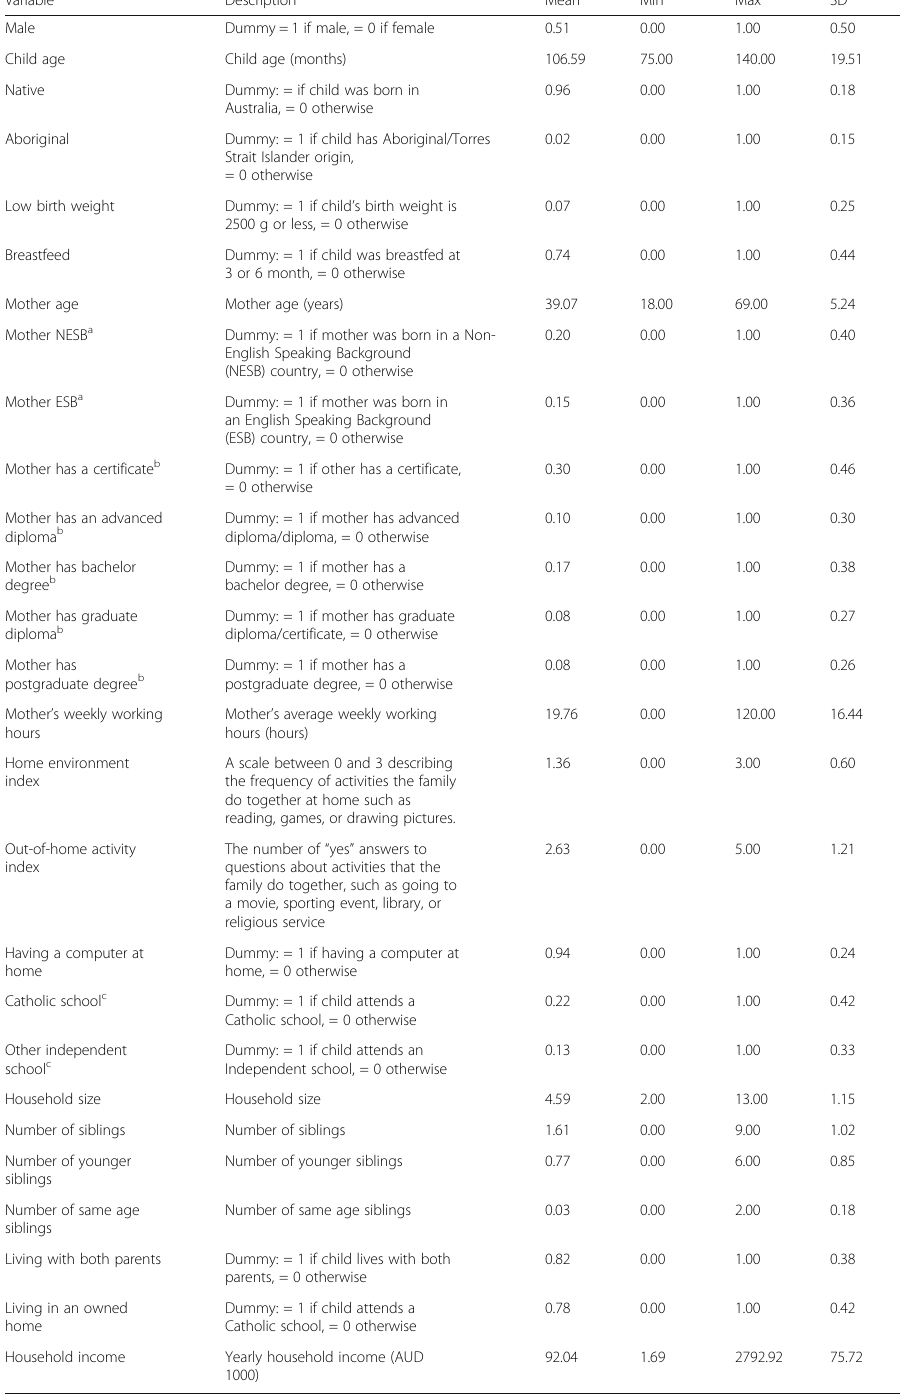
Table 5 Variable description and summary